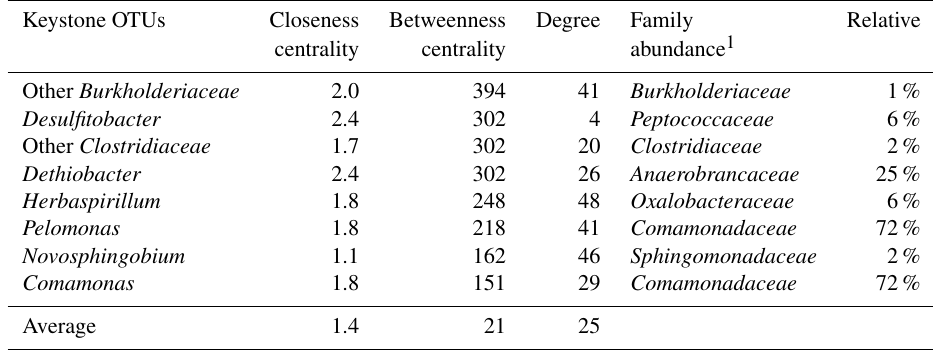
Table 4. The “keystone genera” of the total microbial communities in Outokumpu fractures. Keystone